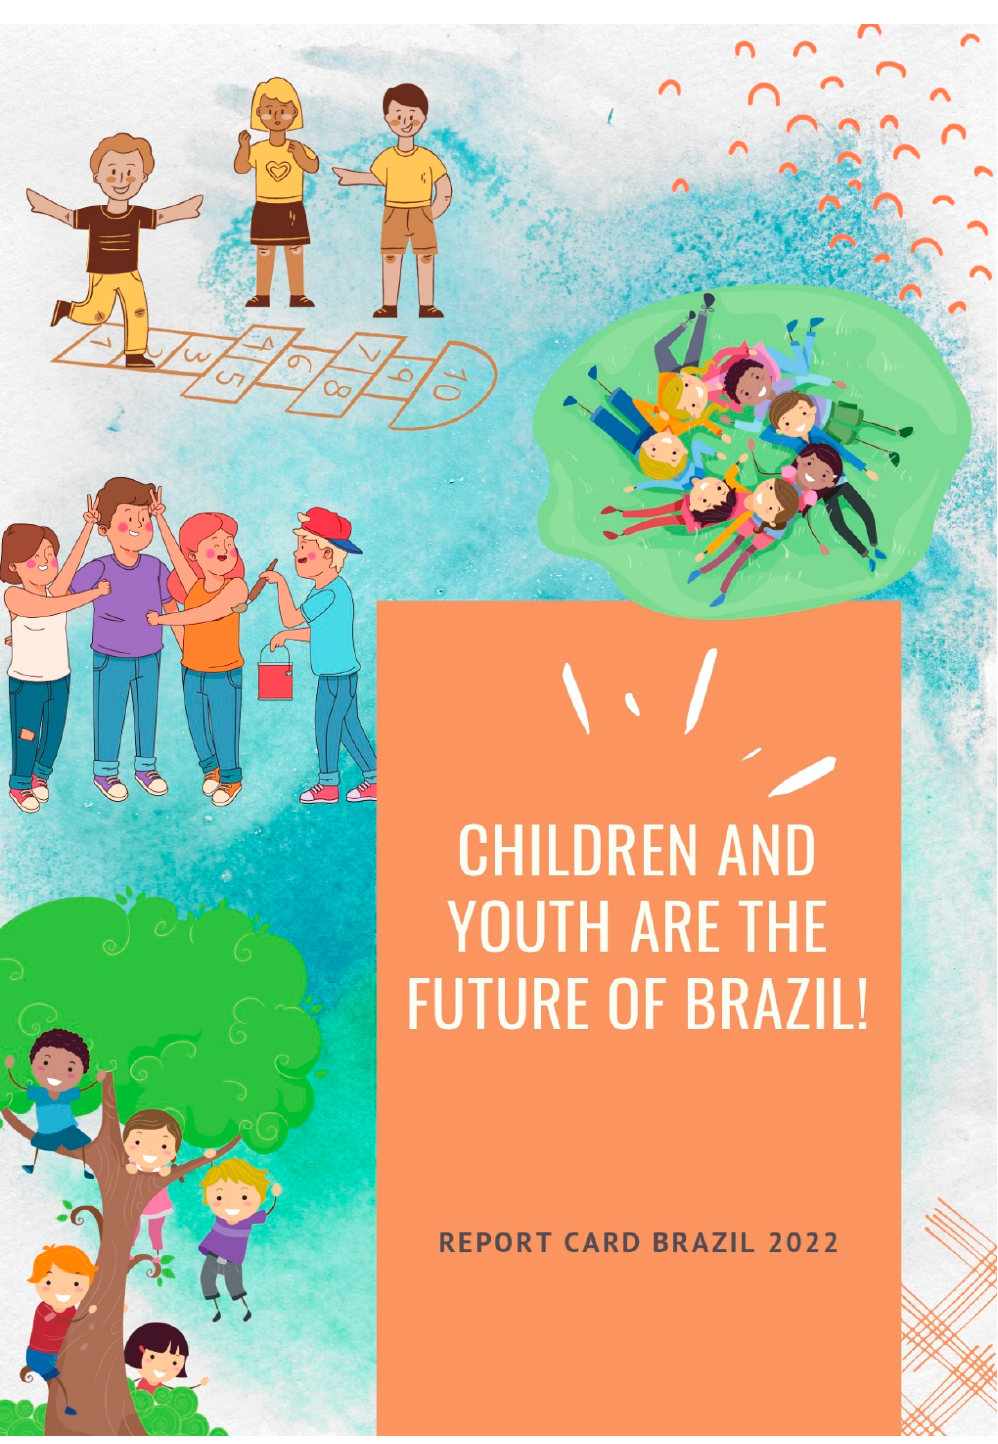
Figure 1. Front cover of the Report Card Brazil 2022.